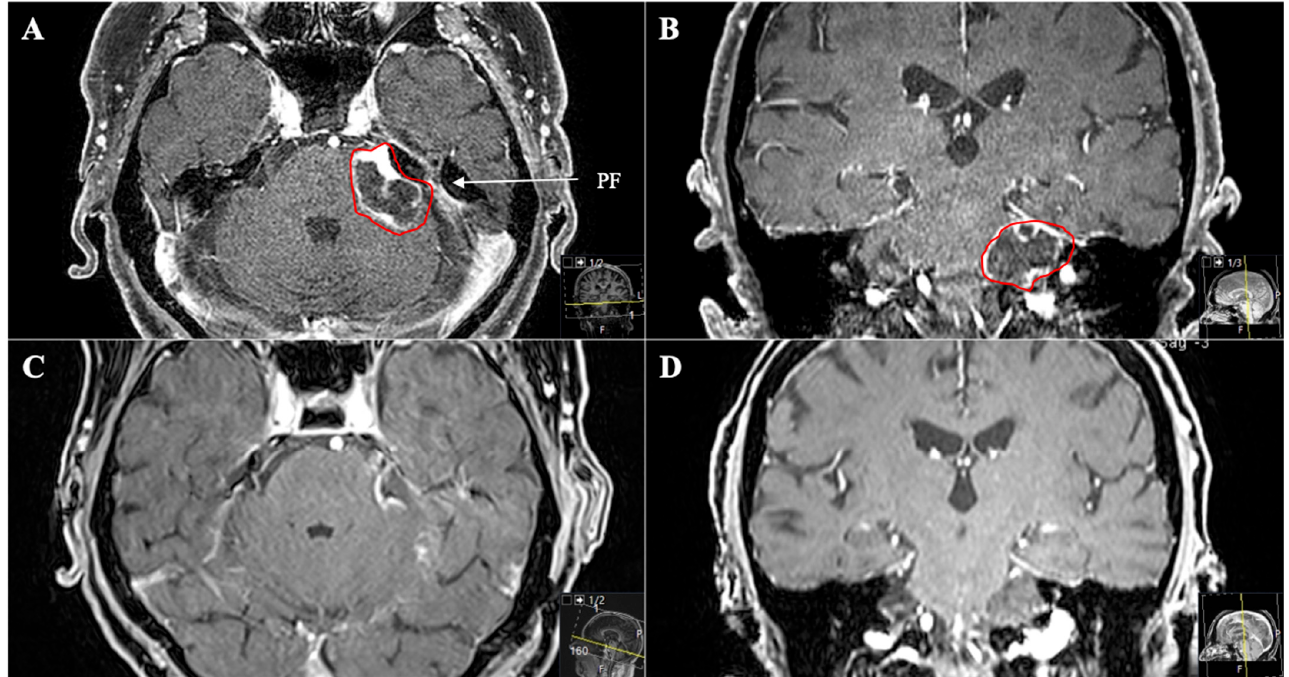
Figure 6. A 53-year-old female patient presented with vomiting, slight ataxia, facial pain and trigeminal hypesthesia (V1,V2) for three months. ( A ) Preoperative axial and ( B ) coronal T1-weighted gadolinium-enhanced MRI, showing a space-occupying cystic trigeminal schwannoma invading the cerebellopontine angle (Samii Type B). ( C ) Postoperative axial and ( D ) coronal MRI control, indicating complete resection via a retrosigmoid approach. Postoperatively, new temporary slight hypoacusis and facial neve palsy (House and Brackmann Grade III) occurred.